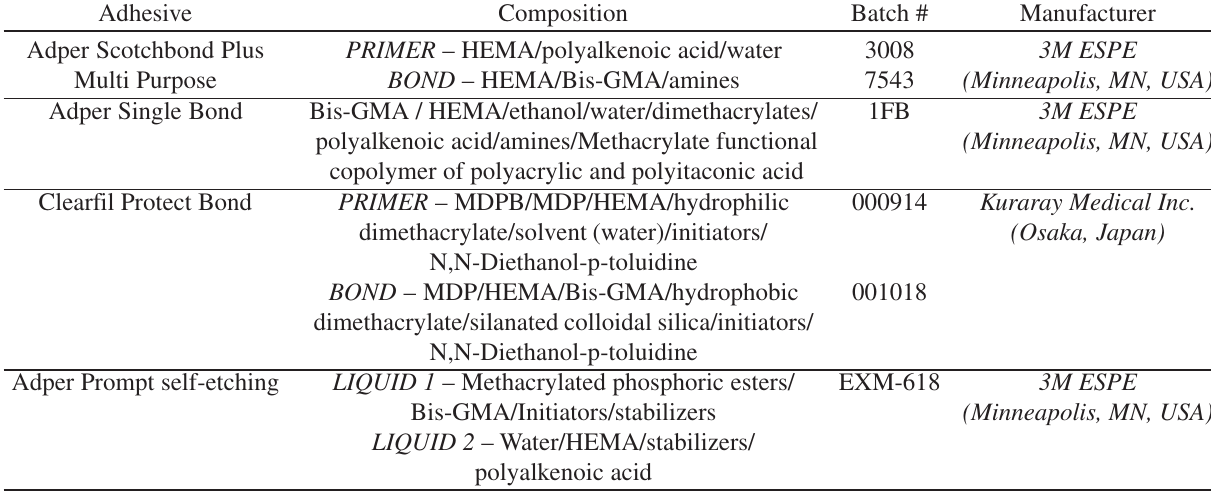
Table 1. Composition and corresponding batch number for each adhesive system tested in this study.